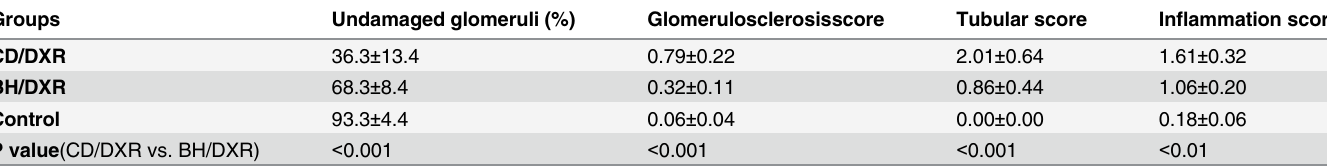
rats. In parallel with less proteinuria and morphological damage, inflammation was signifi- cantly milder in BH/DXR rats than in CD rats (Fig 3G – 3I). Milder fibrosis was associated with less oxidative stress and inflammation Fibrosis was strikingly more intense in CD/DXR than in BH/DXR rats as demonstrated by Sir- ius red staining (Fig 3J and 3K). Fibronectin immunostaining was detected only in 5.2±0.6% of the scanned areas in the saline-injected control groups, but increased significantly in the DXR- injected CD group. Significantly less fibronectin staining was detected in BH/DXR than in CD/ DXR rats (Fig 3L and 3M). TGF- β 1 and CTGF mRNA levels in the kidney cortex were not significantly different in the control groups compared to DXR-injected BH rats, but were significantly elevated in the CD/DXR group (Fig 4A and 4B). COL1A1 mRNA levels were elevated in DXR-injected rats, but the elevation was significantly higher in the CD/DXR group than in the BH/DXR group (Fig 4C). Nephrin is an important component of the podocyte foot processes forming the slit dia- phragm. It plays an important role in the maintenance of the structural integrity and the func- tional soundness of the slit diaphragm [32]. Nephrin mRNA levels decreased in the kidney cortex of the CD/DXR group, but it was not reduced in the BH/DXR group (Fig 4D) support- ing further a milder glomerular damage in BH/DXR rats. The mRNA levels of pro-inflammatory monocyte chemotactic protein 1 (MCP-1) (Fig 4E) and pro-oxidant markers: p91 phox and p47 phox (Fig 4F and 4G) increased in both DXR-injected groups; however the elevation was milder in the BH/DXR group. 4-hydroxy-2-nonenal and nitrotyrosine. In the background of more severe kidney func- tion deterioration demonstrated by proteinuria and fibrosis markers, severe lipid peroxidation and nitrative stress were detected in the kidneys of DXR-injected CD rats, while very mild changes were seen in the HNE or NT stained paraffin sections from the BH/DXR rats. Less staining was corroborated by Western blot demonstrating significantly more HNE and NT in CD than in BH rats 8 weeks after DXR administration (Fig 5).